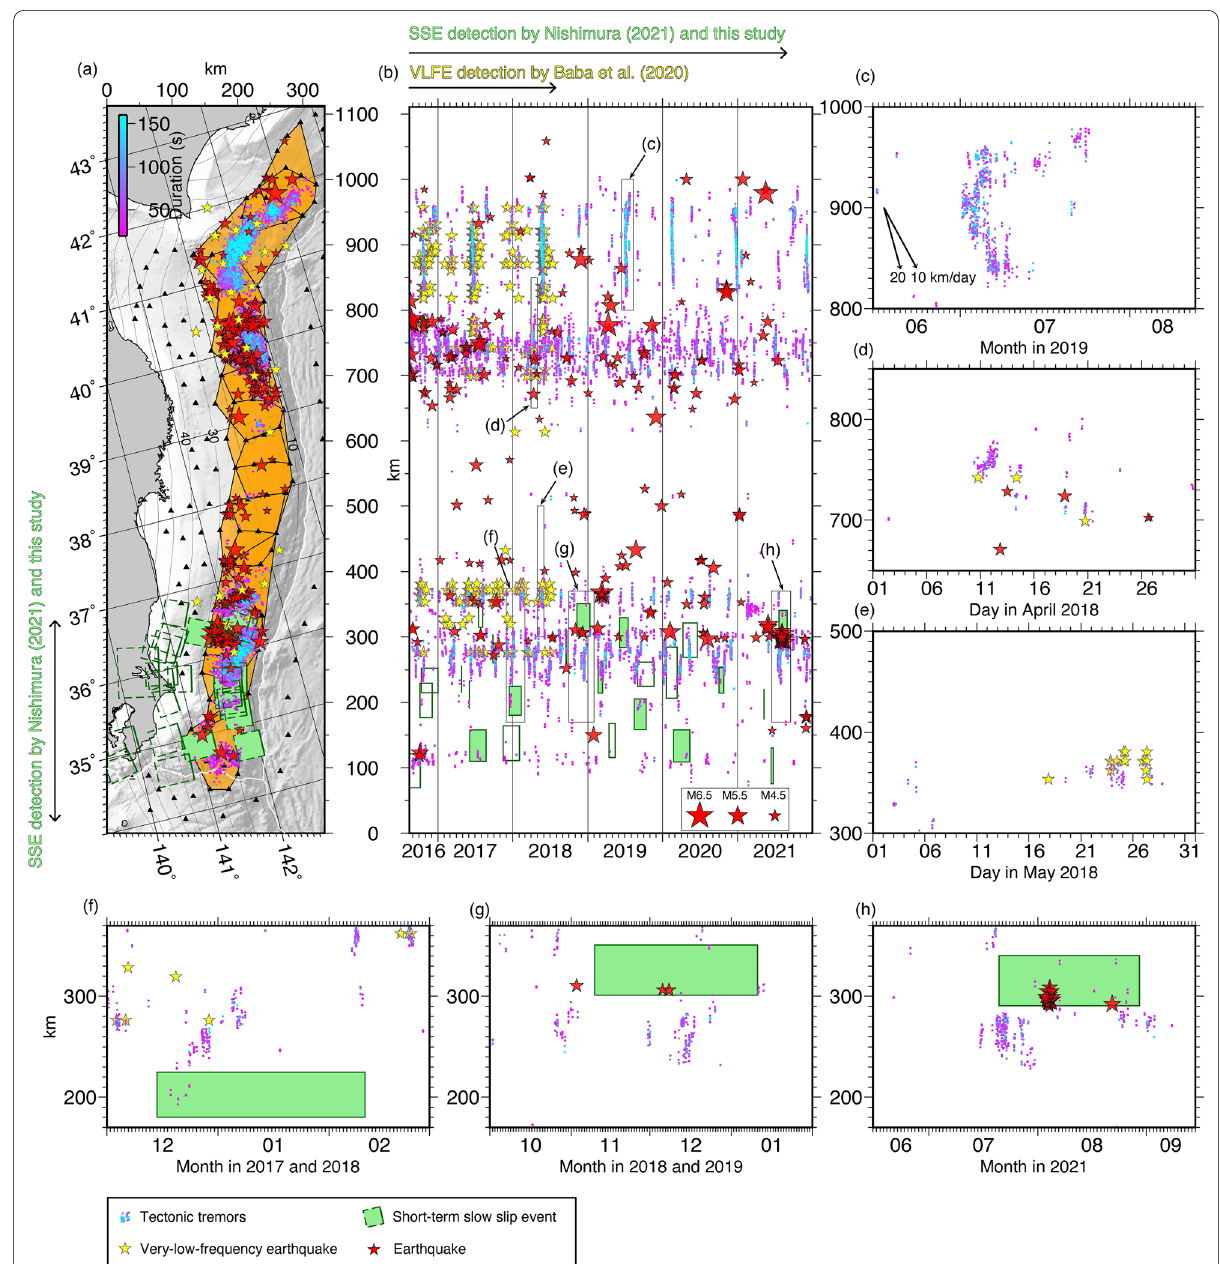
Fig. 5 Tectonic tremor activity in the Japan Trench from August 2016 to December 2021. a Epicenters of the tectonic tremors. Colored points indicate the epicenters of the tremors. Yellow and red stars represent VLFEs (Baba et al. 2020) and M j 4 fast earthquakes, respectively. The ≥ fast earthquakes are from the Japan Meteorological Agency (JMA) catalog. Open and solid dashed green rectangles denote deep and shallow short-term SSEs, respectively (Nishimura 2021). The upper edges of the SSE fault models are indicated by the green solid lines. Black triangles represent S-net stations. The orange shaded polygons are subregions used for tremor detection by Nishikawa et al. (2019). The upper surface of the subducting Pacific Plate is indicated by the black contours at 10-km-depth intervals. b Spatiotemporal distribution of the tectonic tremors. We used Japanese Standard Time (UTC 9 h). c – h Enlarged views of ( b ). The spatiotemporal windows of c – h are shown in ( b +